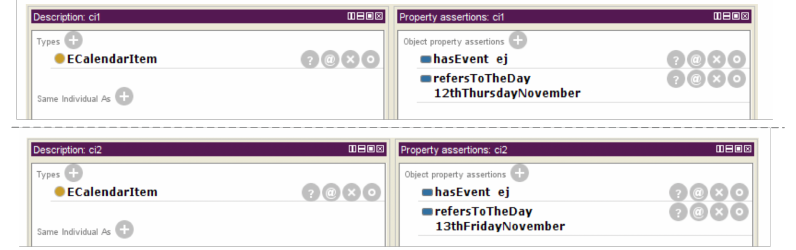
Figure 6. Individuals c 1 and c 2 defined using